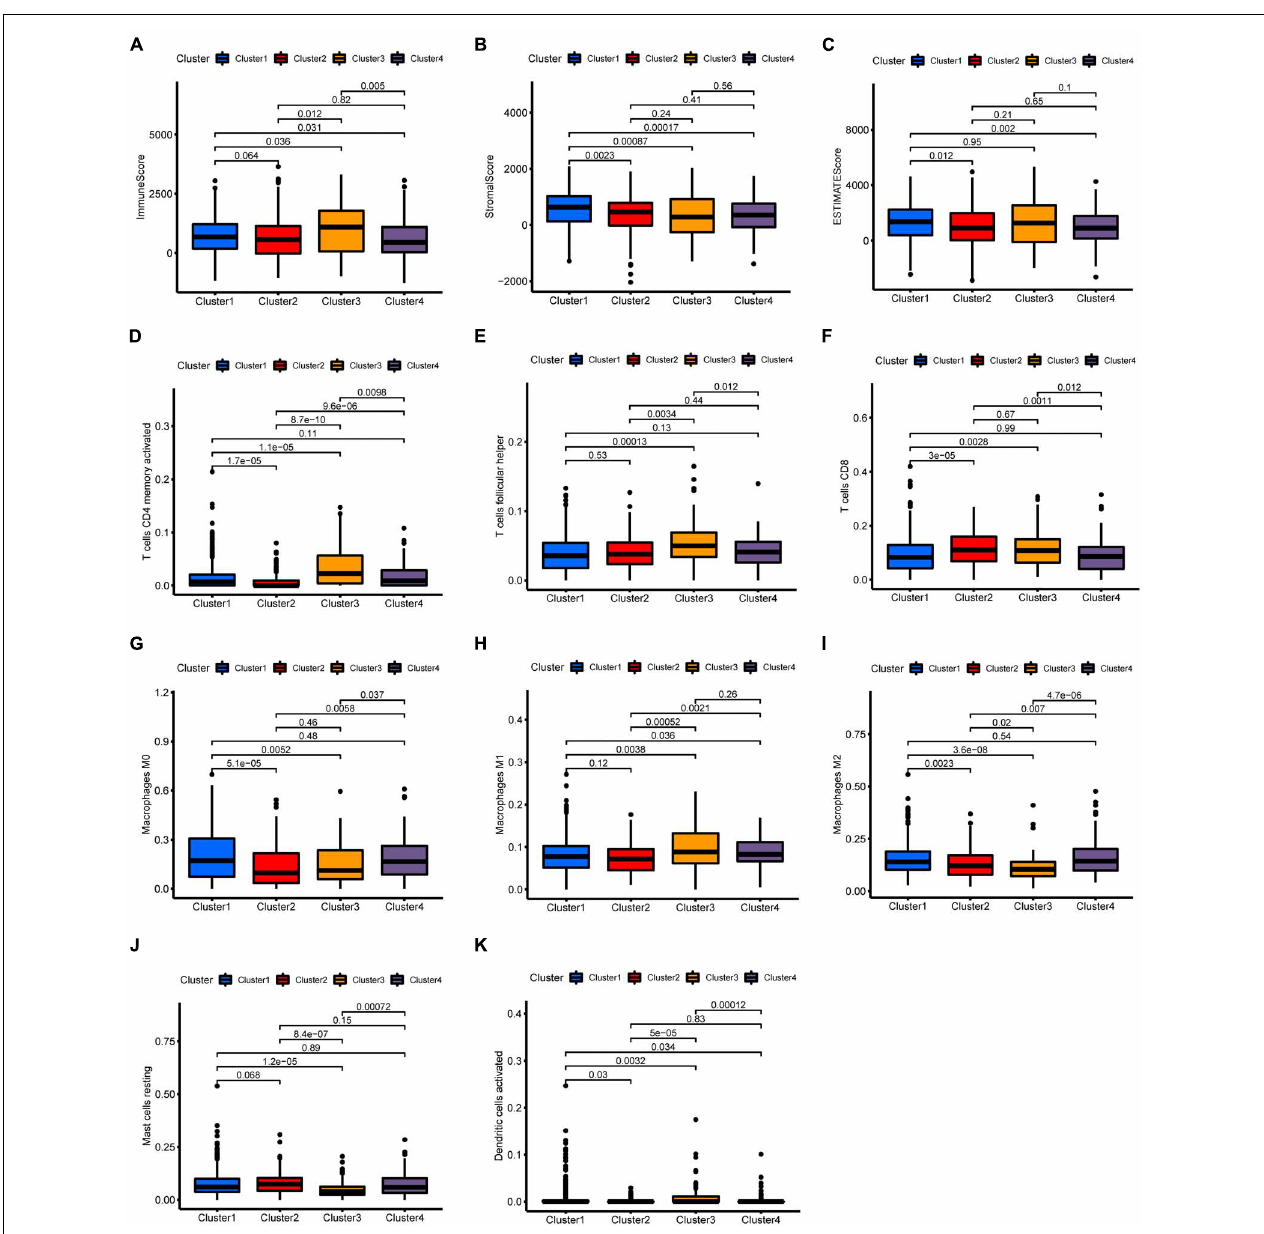
FIGURE 3 | Immune characteristics among four m6A-related lncRNA BC clusters. (A–C) Different expression of immune score (A) , stromal score (B) , and ESTIMATE score (C) in four BC clusters. (D–K) Differences in the levels of infiltration of CD4 memory T cells, follicular helper T cells, CD8 T cells, M1 macrophages, M0 macrophages, M2 macrophages, resting mast cells, and dendritic cells in four BC clusters.